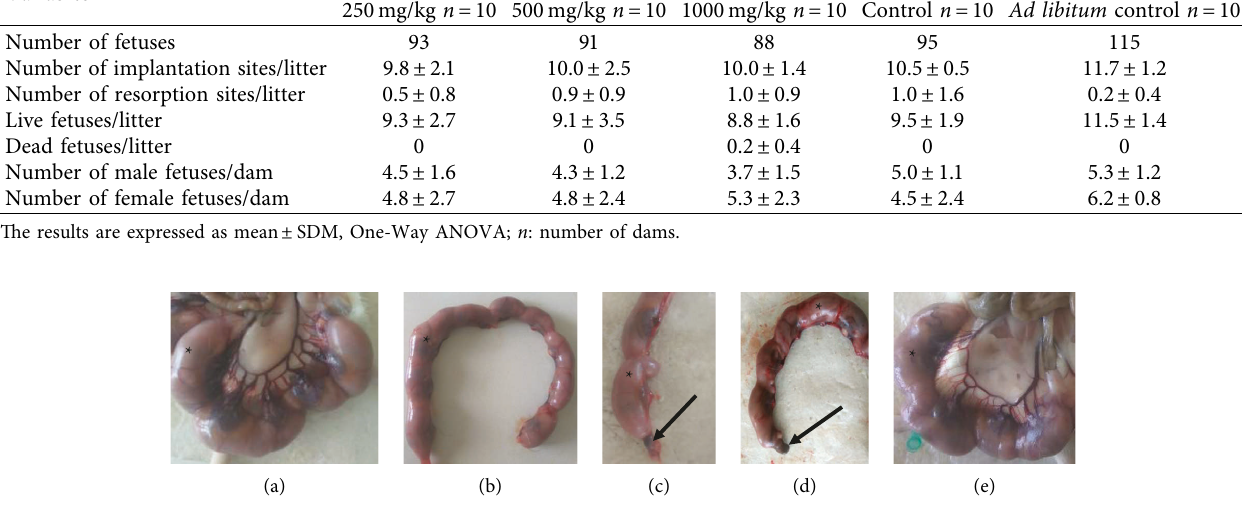
Table 2: Pregnancy outcomes of rats treated with 70% ethanol leaf extract of Syzygium guineense . Variables